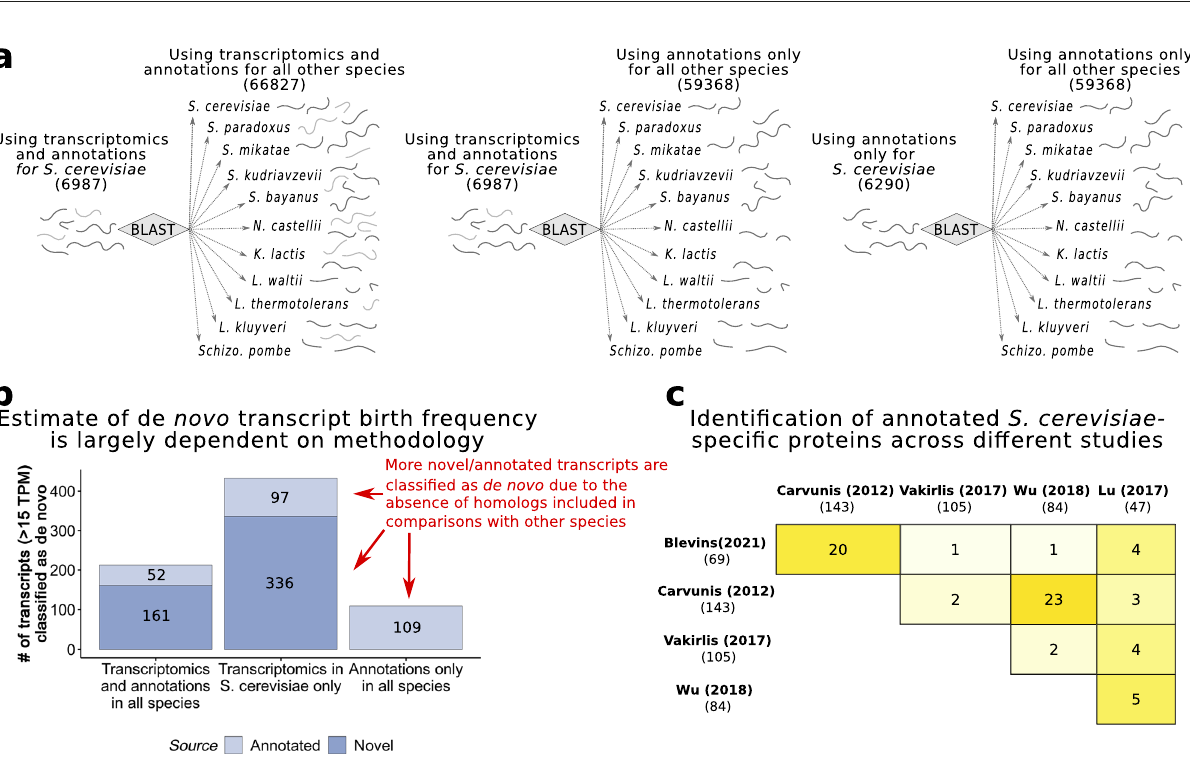
Fig. 2 Identi fi cation of de novo transcripts in S. cerevisiae . a Pipeline for the identi fi cation of de novo transcripts and other conservation classes. For each of the S. cerevisiae transcripts which were expressed above our threshold (>15 TPM), we estimated their phylogenetic conservation using genomic synteny and homology searches. b Identi fi cation of genomic synteny blocks by using MUMs. Diagram illustrating maximal unique matching subsequences (MUMs) across a chromosome in different species of the Saccharomyces genus. The synteny blocks were de fi ned by clustering contiguous MUMs in close proximity. c Examples of different classes of transcripts depending on their phylogenetic conservation. Diagram of a hypothetical syntenic genomic region shared by all 11 species with different classes of genes indicate. d Number of transcripts depending on their phylogenetic conservation. The genes were divided in three classes: ‘ de novo ’ (213 transcripts), ‘ genus-speci fi c ’ (251 transcripts) and ‘ conserved ’ (4,409 transcripts). We found that 213 transcripts were likely to have arisen de novo over the past ~20 million years i.e. there were no homologues in species more distant than S. mikatae (purple). Only transcripts expressed at more than 15 TPM were considered here. Below are the number of transcripts identi fi ed at each internal branch in the tree leading to S. cerevisiae , before and after applying different computational fi lters. e The majority of de novo transcripts are not present in the annotations and are expressed in different conditions. Number of transcripts in each class that correspond to annotated transcripts (light grey) and unannotated transcripts (dark grey). Fraction of transcript expression above 15 TPM in rich media (yellow), in oxidative stress (red), or both conditions (blue). The vast majority of